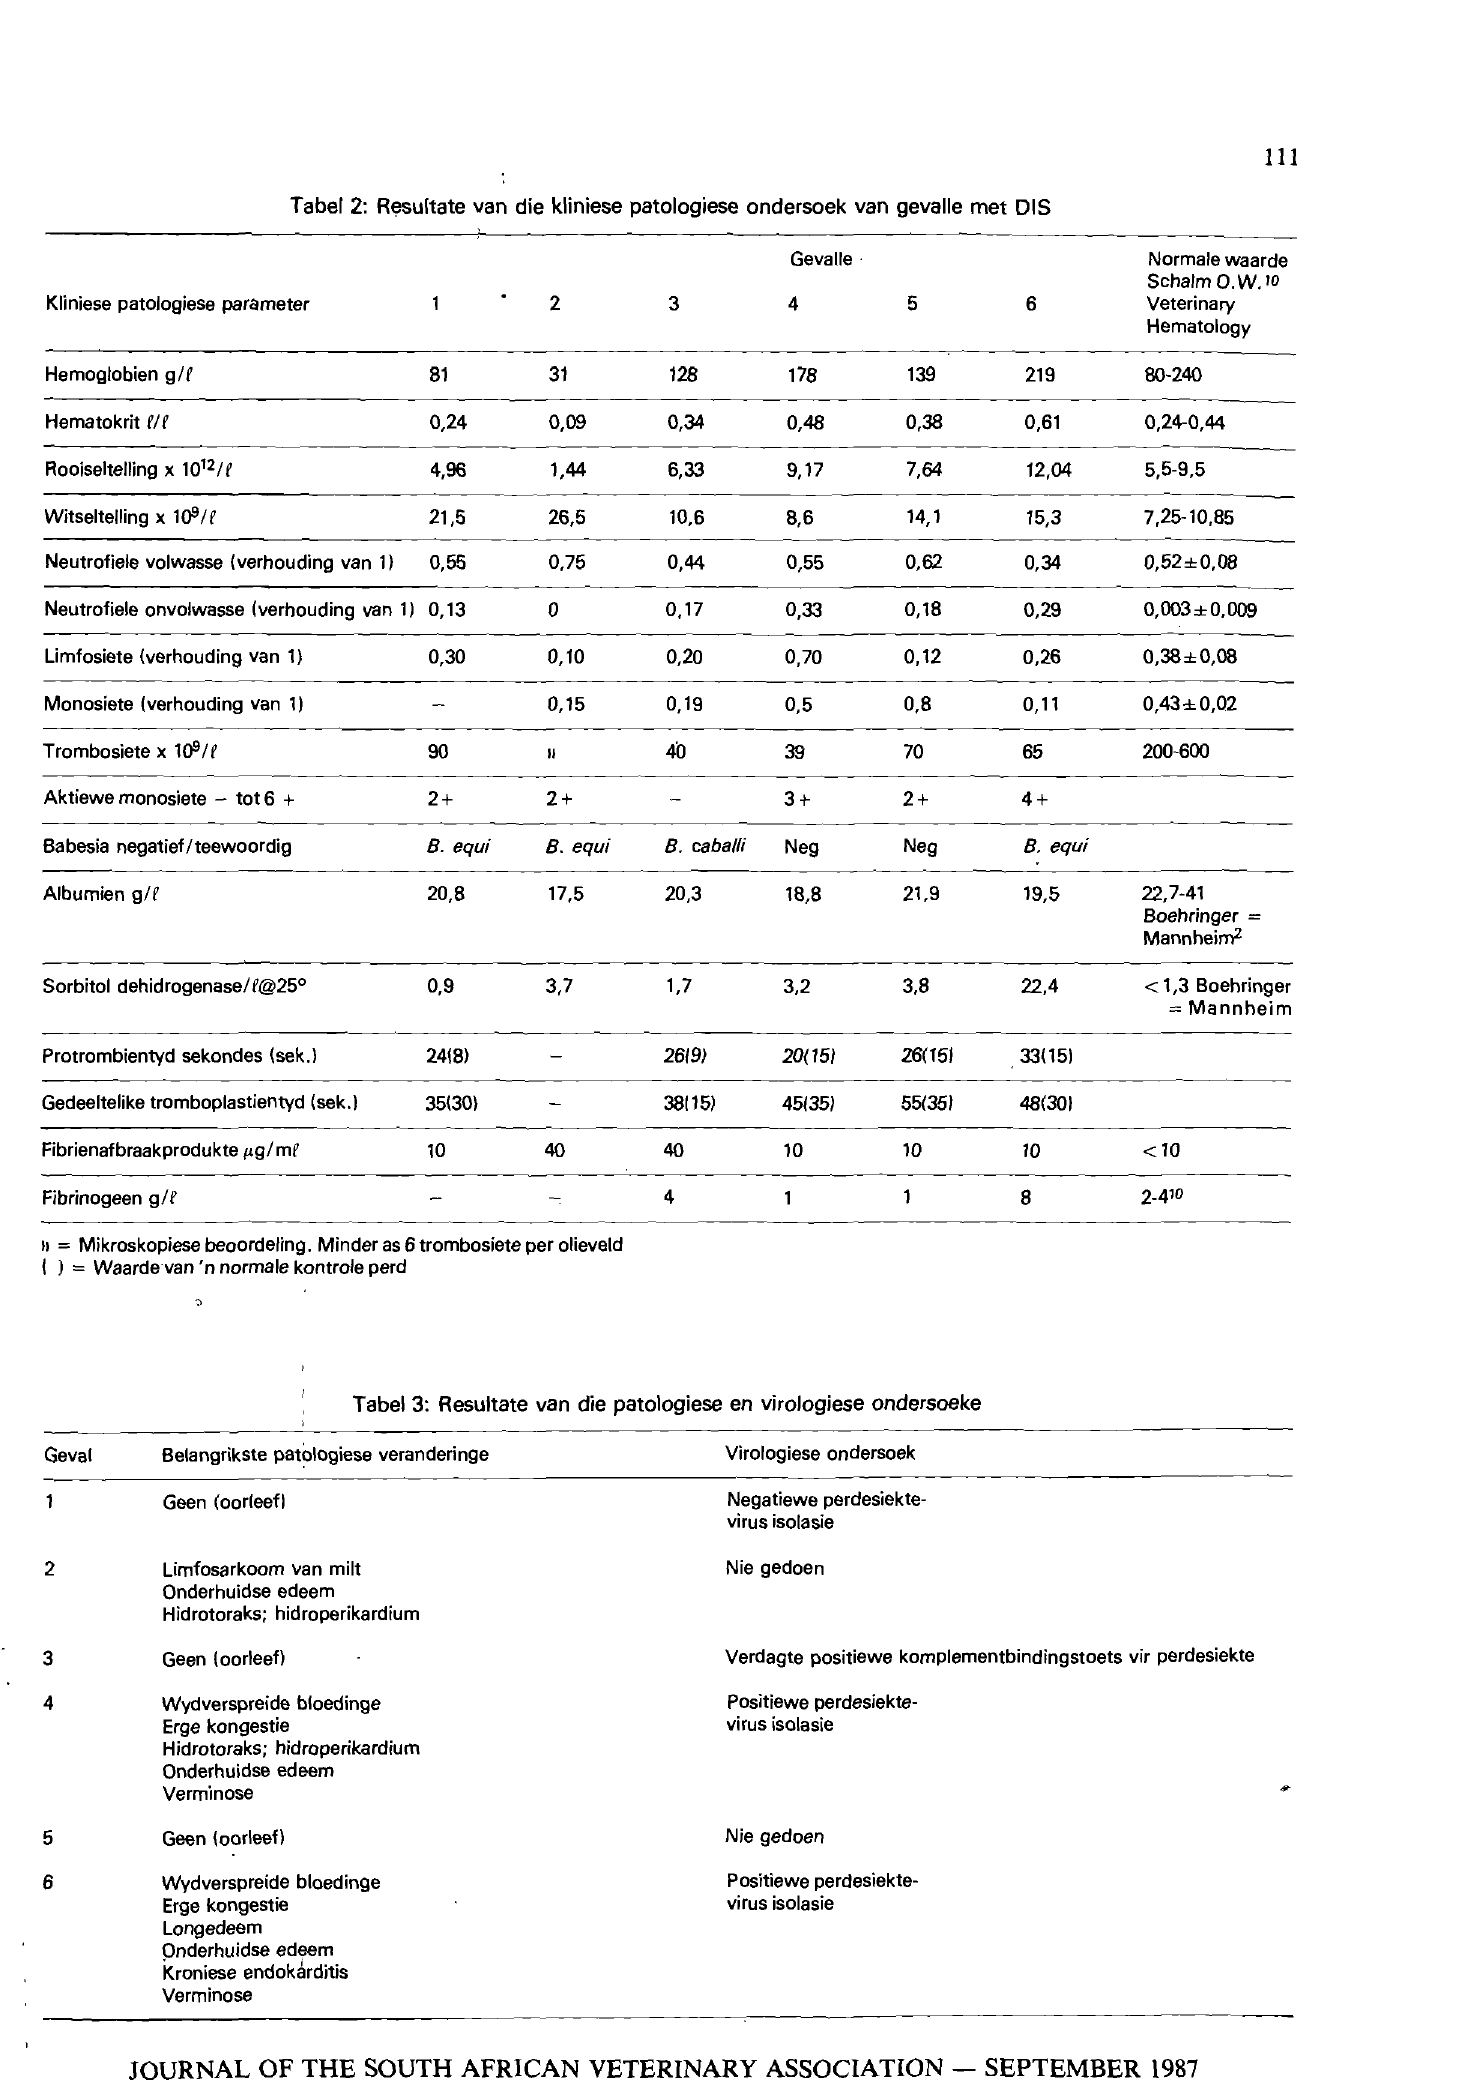
Taber 2: Resultate van die kliniese patologiese ondersoek van gevalle met DIS